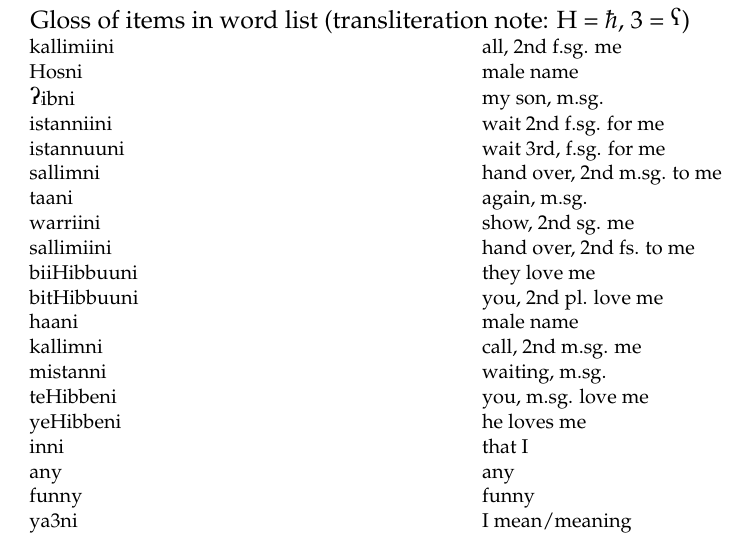
Table 1. Triggers of palatalization in Cairene (/t, d/ from Haeri 1996a, p. 51; Youssef 2015, pp. 25– 27; /n/ from my own informal